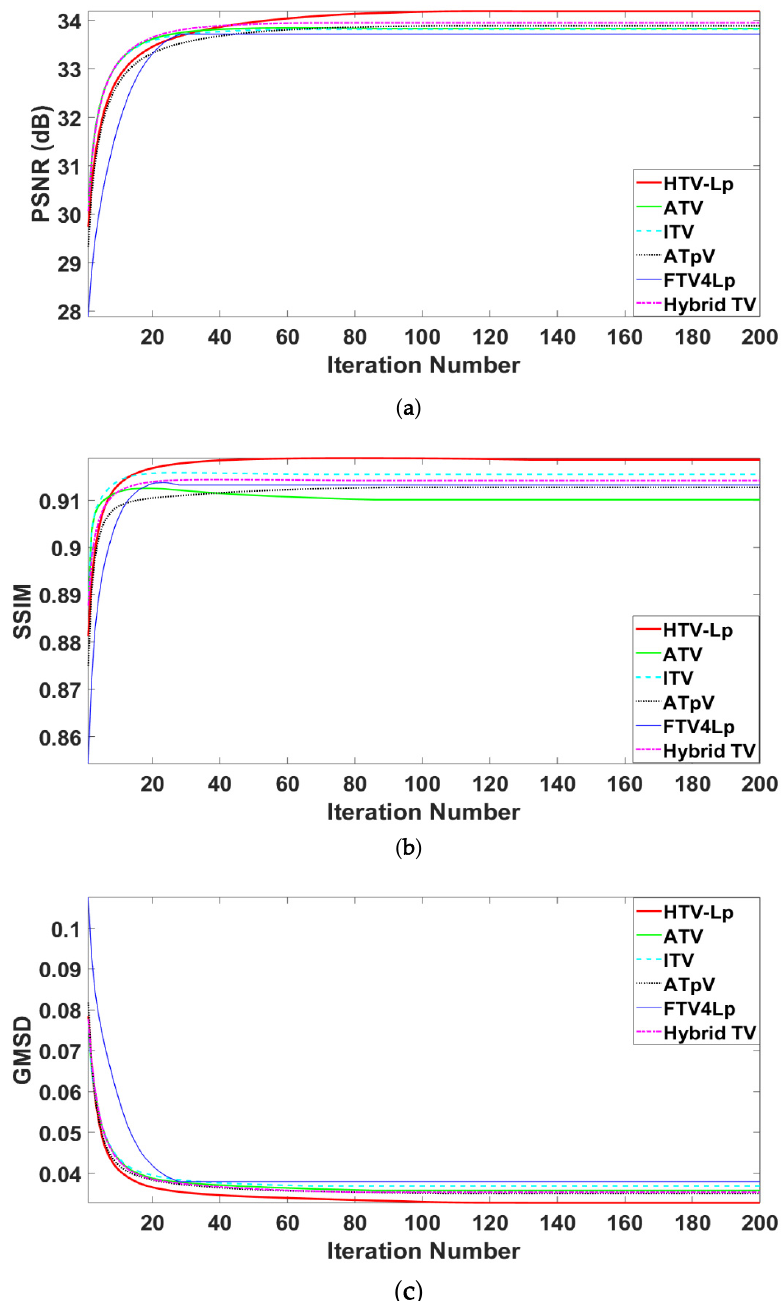
Figure 5. Dynamic iterative curves with di ff erent evaluation metrics. ( a ); ( b ); ( c ) are figures illustrating e ff ects for the degraded “Car” image with the motion blur kernel (M, 10, 10) and Gaussian noise standard deviation of 3 on PSNR, structural similarity (SSIM), gradient magnitude similarity deviation (GMSD), respectively.